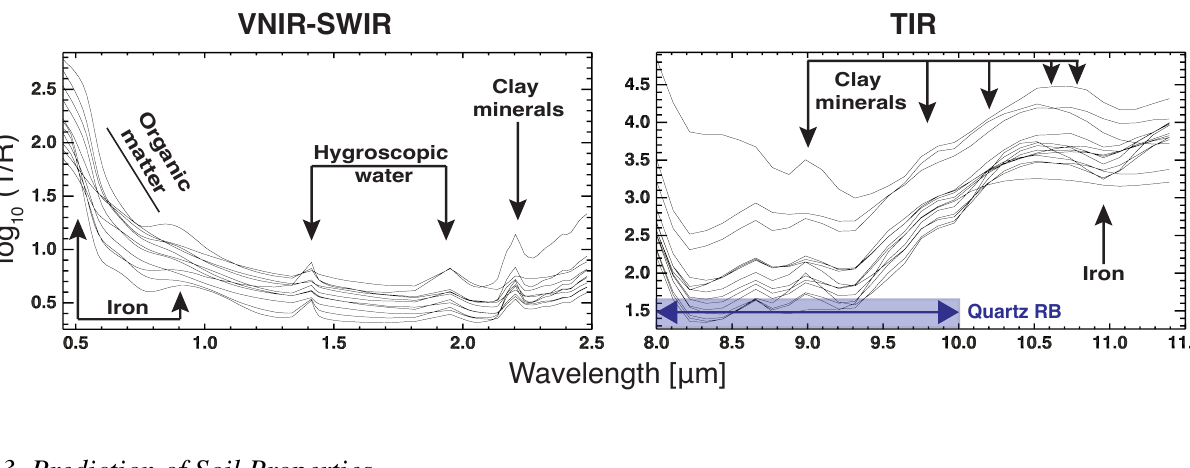
(1 /R ) ) spectra for the VNIR-SWIR and the Figure 5. Soil absorption (transformed to log 10 TIR, resampled to HyMap and TASI-600 spectral characteristics, as they are entered into the prediction modelling. Locations of the spectral soil features (RB: Reststrahlen